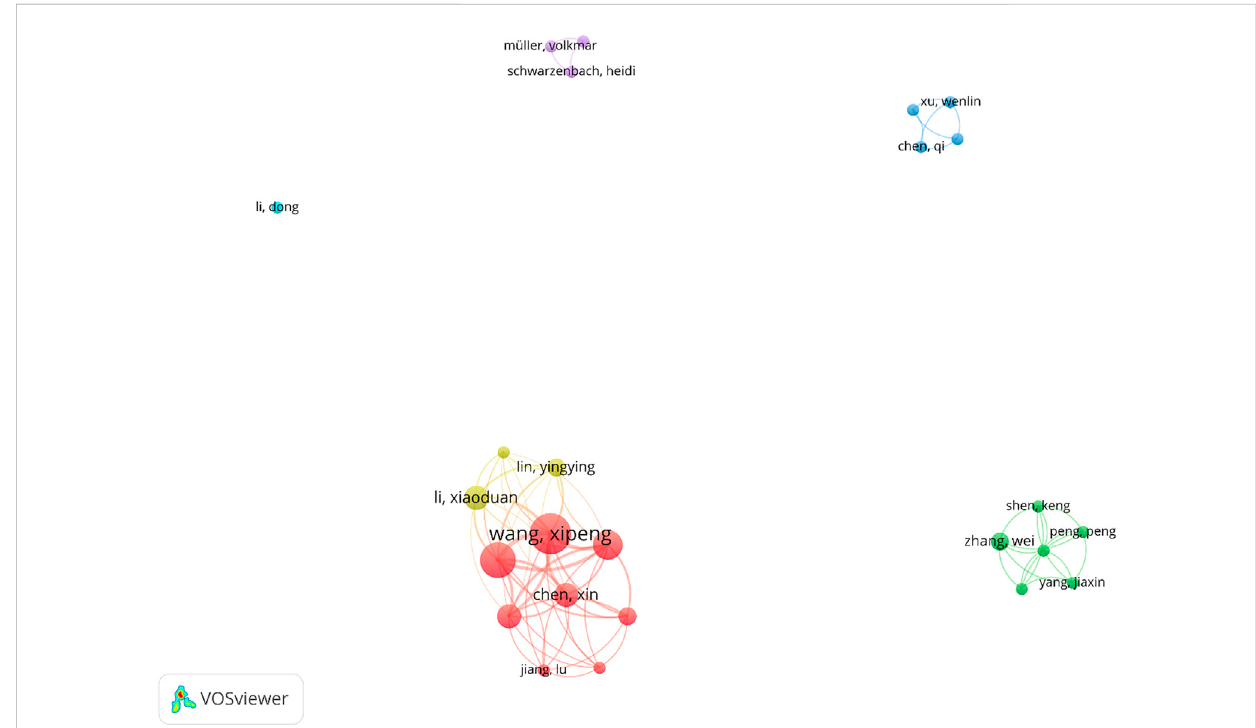
FIGURE 7 Author co-authorship networks (criteria: authors with at least 2 articles in the fi eld of exosome and OEC).